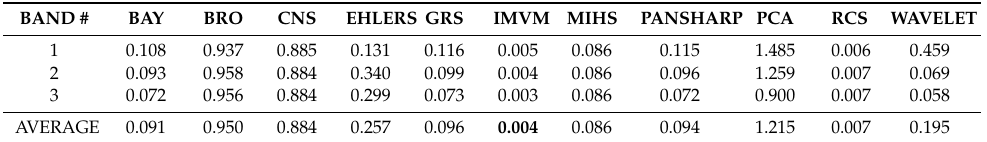
Table 8. Spectral consistency: bias.